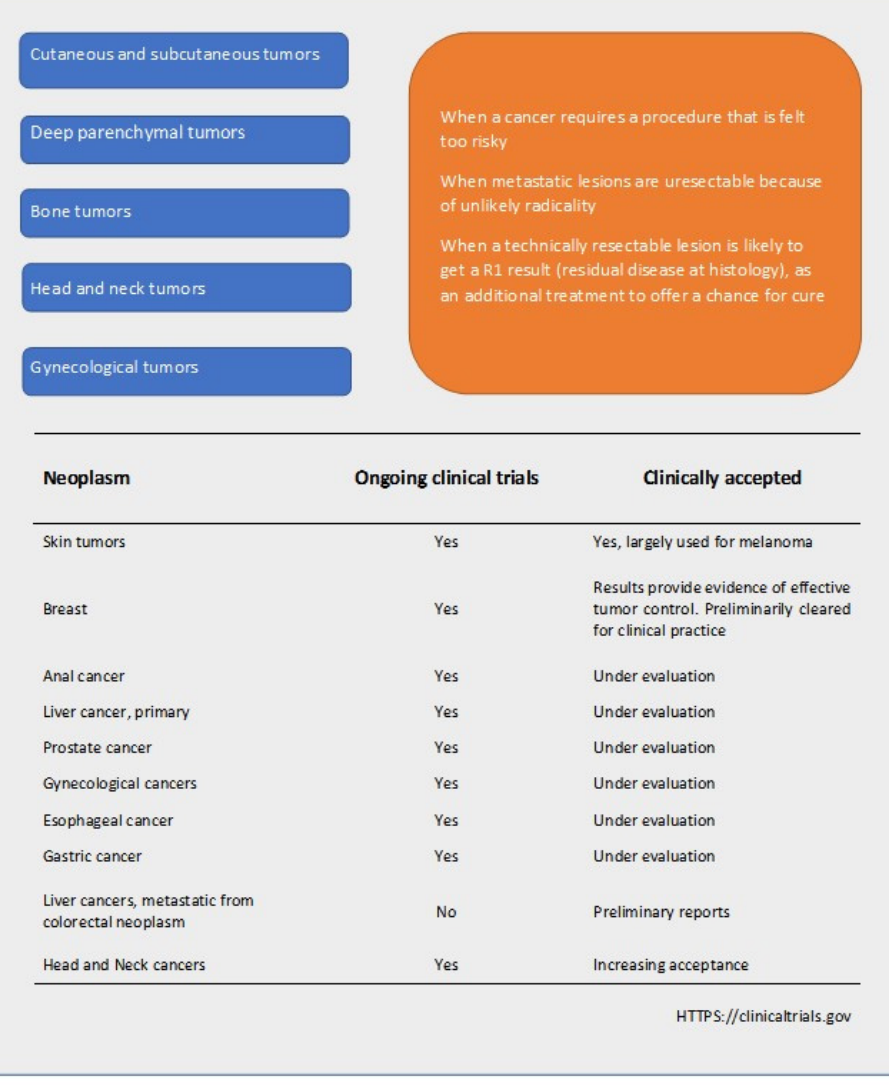
Figure 2. Scheme of the perspective clinical diffusion of electrochemotherapy (ECT) in antitumoral treatments.